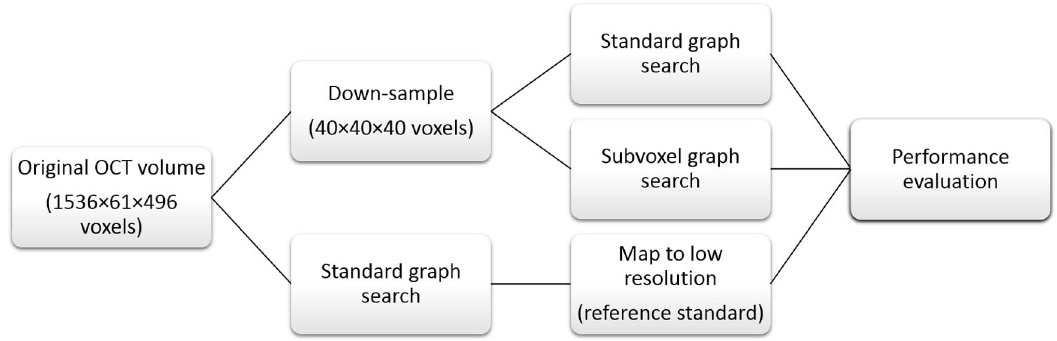
Figure 8. Experiment design for quantitative performance evaluation.